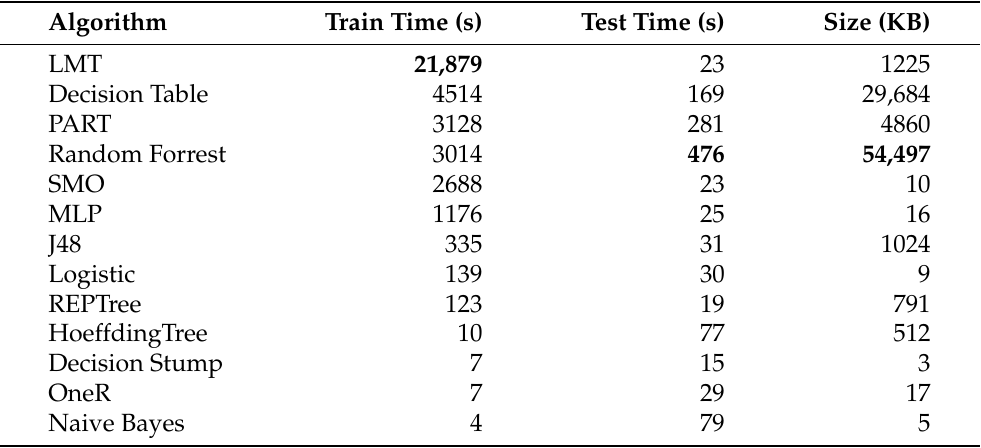
Table 6. Comparison of the size and elapsed time taken during training and